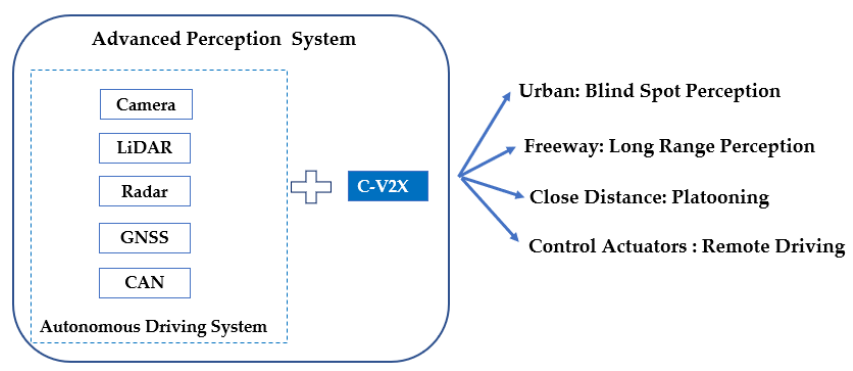
Figure 1. C-V2X Benefits.